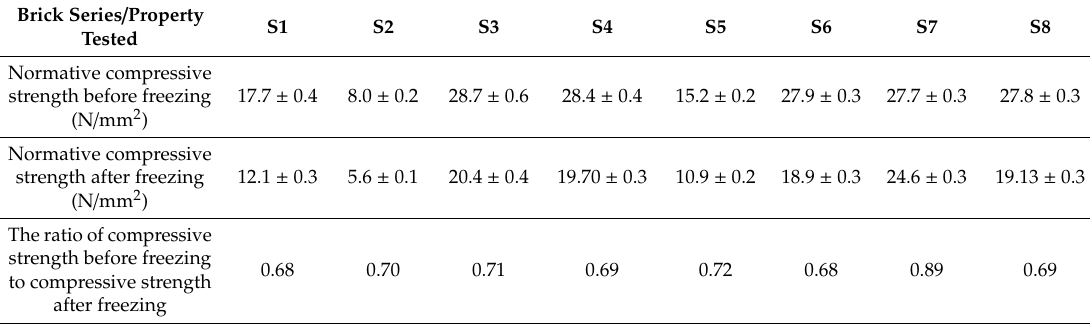
Table 1. Compressive strength of bricks before and after freezing with the corresponding standard deviation and the ratio of compressive strengths pre- to post-freezing.